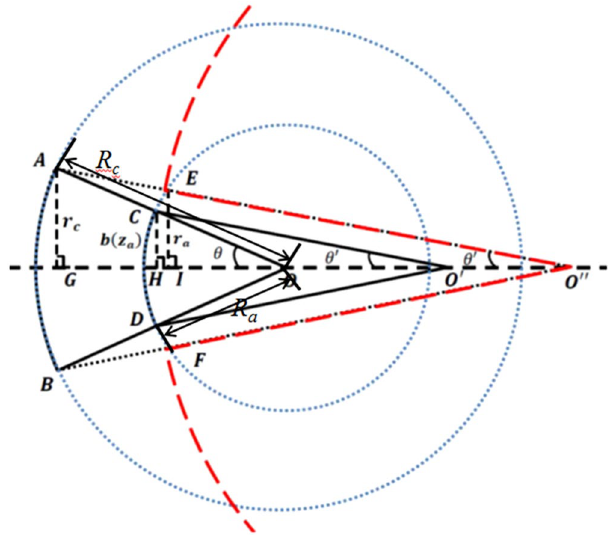
Figure 5. Schematic of the sheet beam electron gun with their parameters.